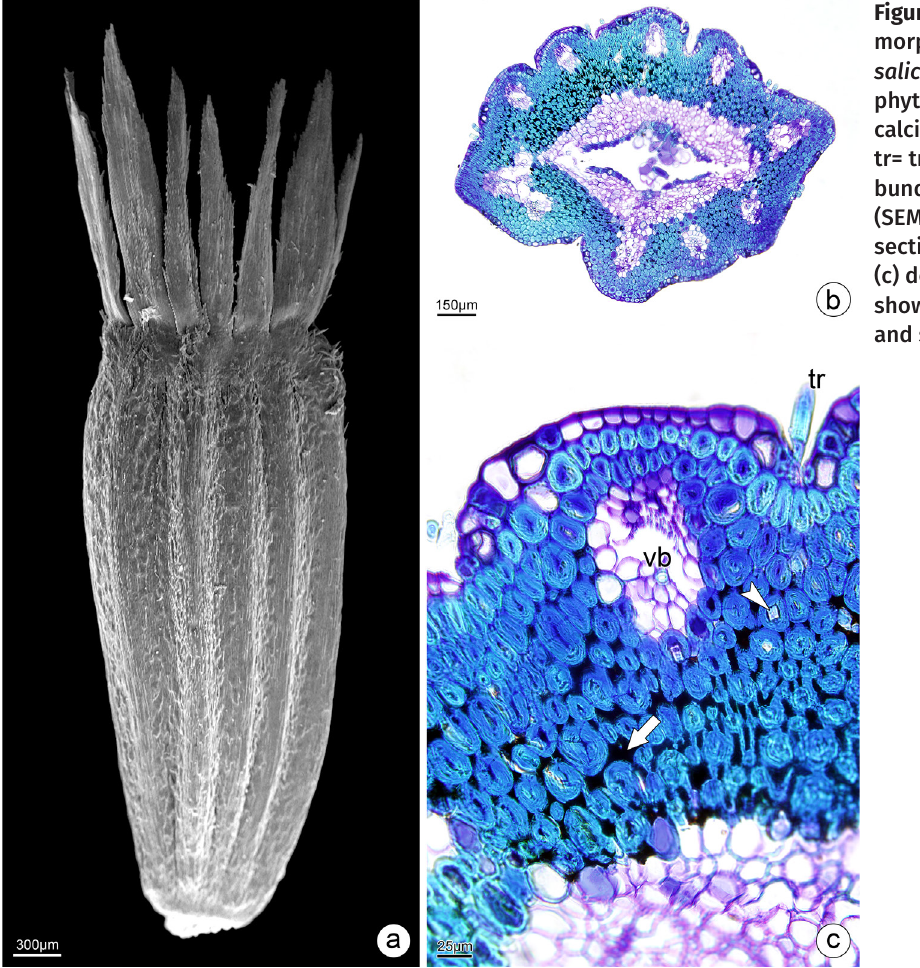
Figure 1. Cypselae morphology of Lychnophora salicifolia . arrow= phytomelanin; arrowhead= calcium oxalate